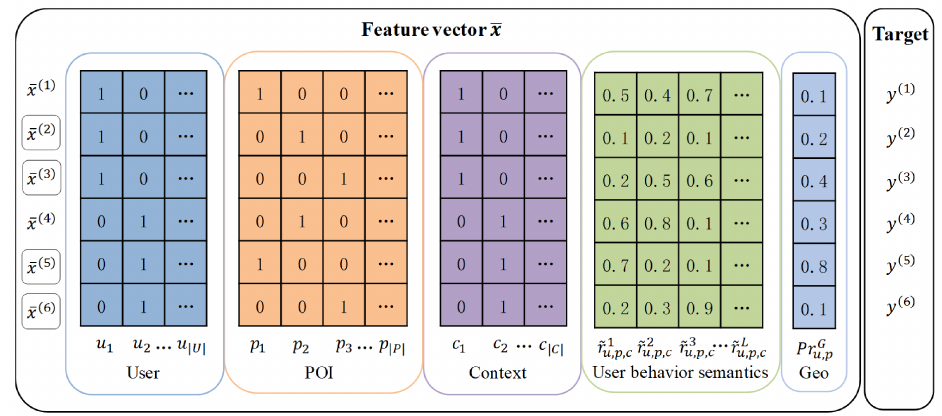
Figure 4. An example for representing a context-specific POI recommendation problem with feature